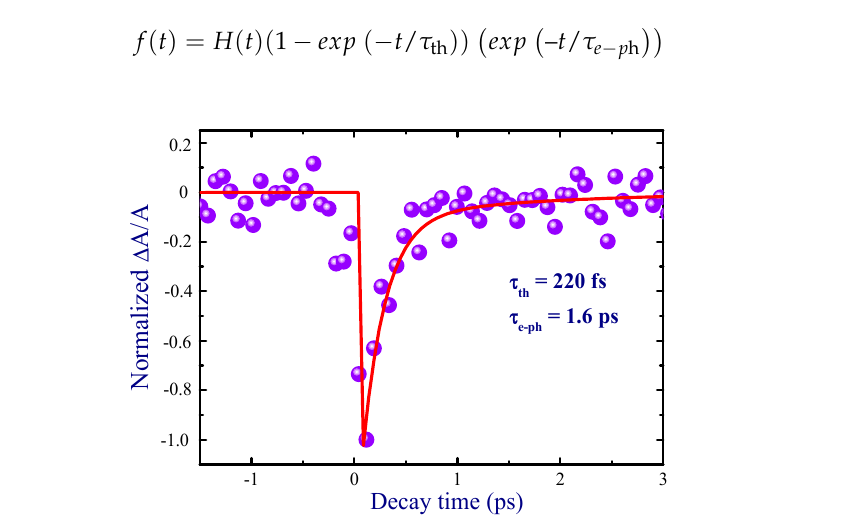
Figure 4. Pump–probe dynamics of Au NP thin film at 400 nm.